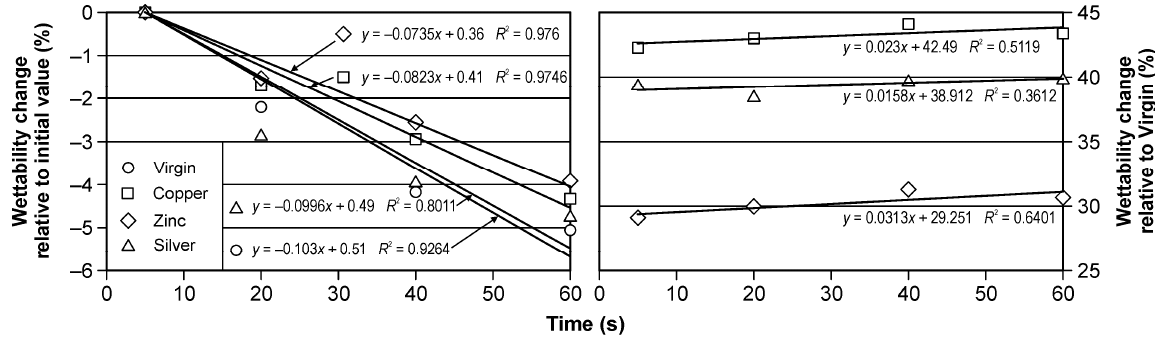
Figure 4. The percentage change of the contact angle in the time for virgin and implanted cellulose: relative to initial value ( left ) and relative to virgin samples value ( right ).